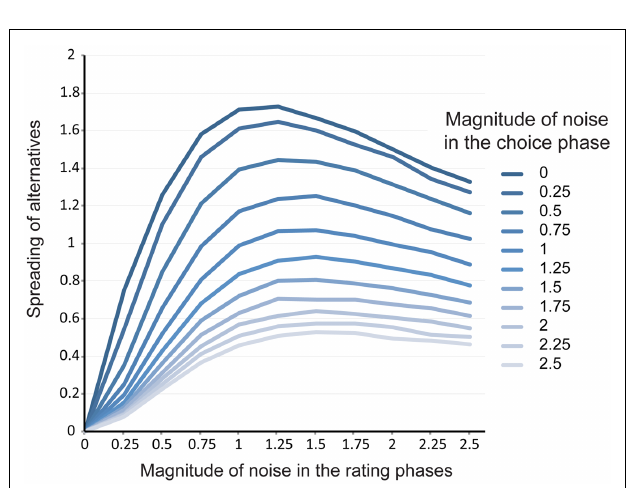
FIGURE 3 | Simulated patterns of preference change across different choice conditions (replication = 10,000). In this simulation, noise in both the rating and choice phase was set at 0.5 (relative magnitude in comparison to the standard deviation of the true preference; see also Figure 4 ). (A) Preference change after difficult choices between two attractive items of the